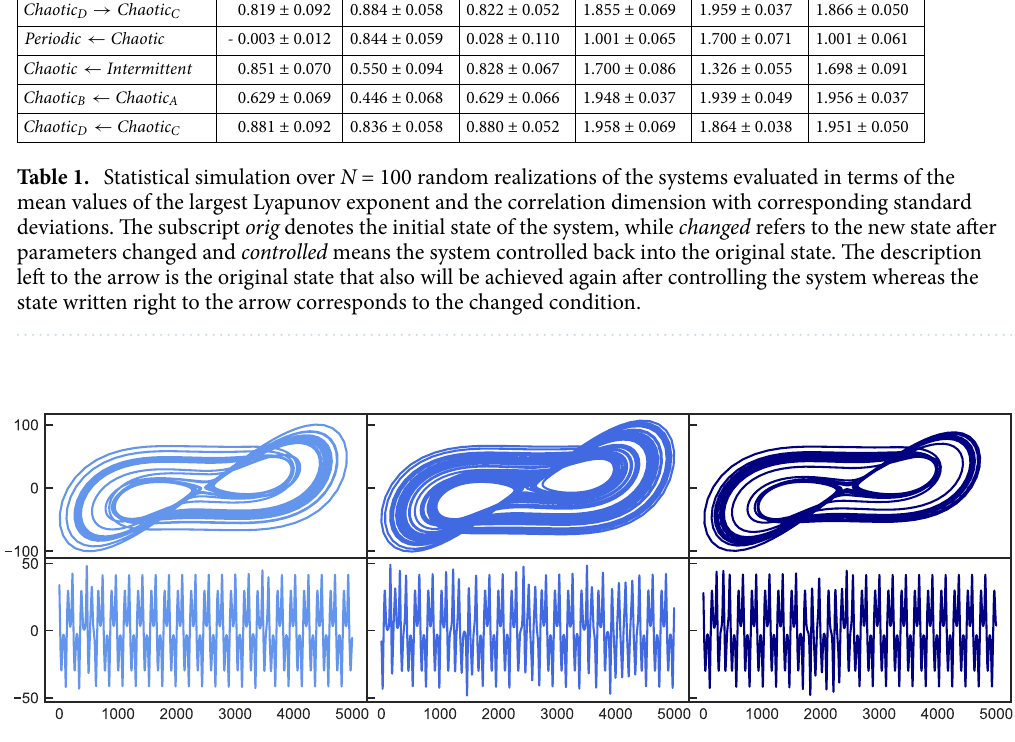
Figure 2. Chaotic to intermittent control. Top: 2D attractor representation in the x–y plane. Bottom: X coordinate time series. Left plots show the original intermittent state which changes to a chaotic state (middle) after tuning the order parameter. After applying the control mechanism, the system is forced into an intermittent state again